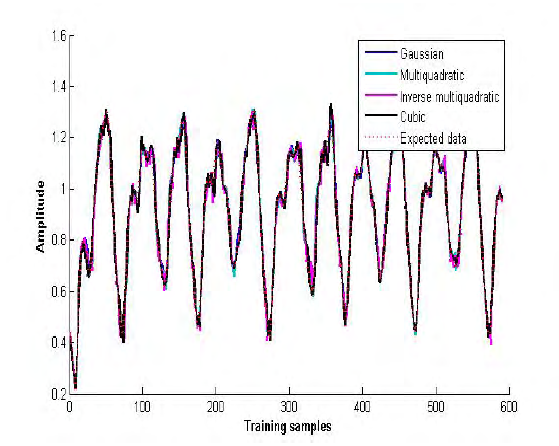
Fig. 10. Training the individual NARX-RBFNNs - Mackey glass